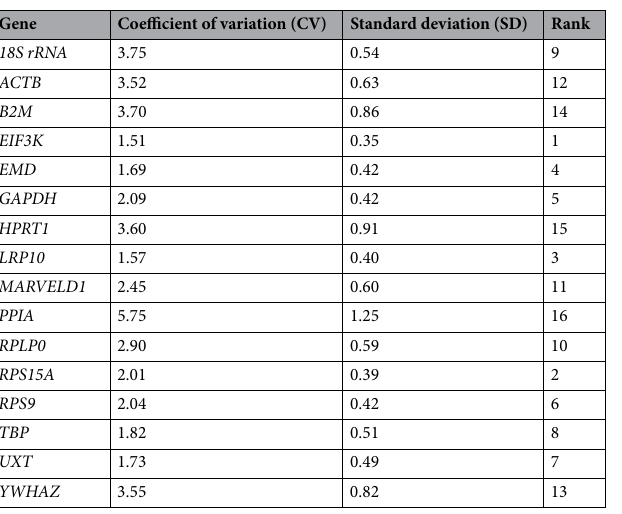
Table 1. Stability of expression of candidate reference genes in bovine SMSCs at the proliferation stage estimated by Bestkeeper algorithm.